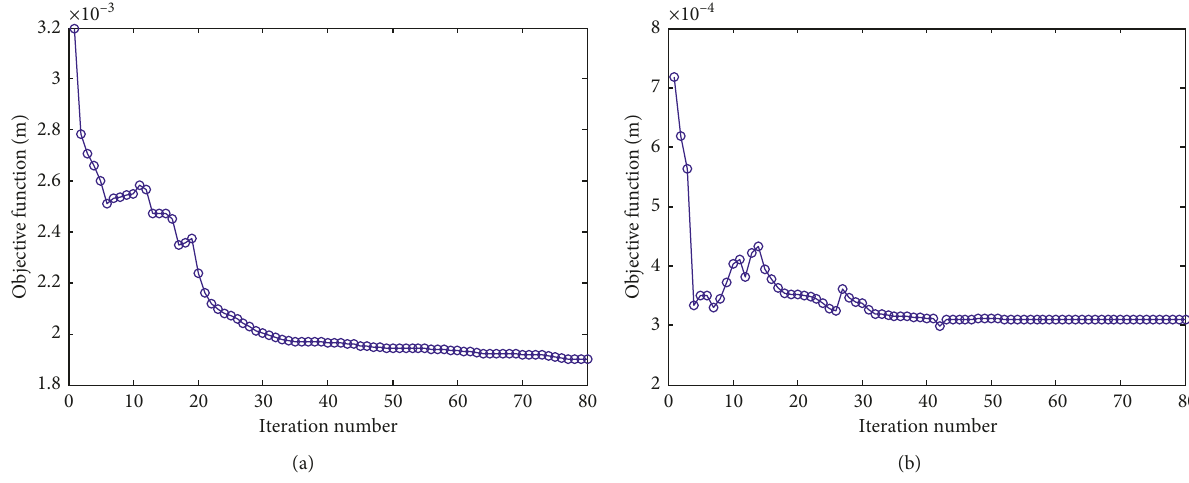
0 , 100 Hz and (b) f (cid:31) [ ]